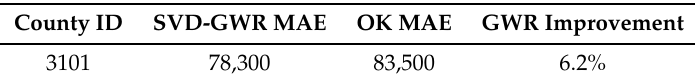
Table 7. GWR over OK in USD.